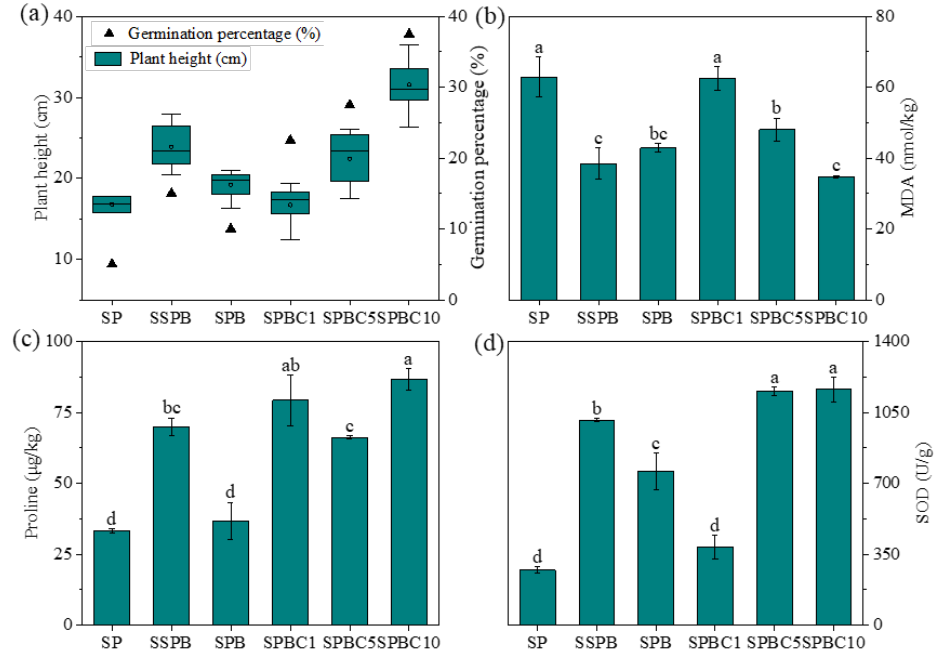
Figure 3. Maize growth and physiological indices in different treatments. ( a ) Plant height and germination percentage; ( b ) MDA content; ( c ) Proline content; ( d ) SOD content. Notes: Different letters indicate significant differences between different treatments ( p < 0.05). “S” represents “unsterilized soil”, “SS” represents “sterilized soil”, “P” represents “plant”, “B” represents “functional bacteria”, “C” represents “biochar”, and the number following the abbreviation represents the proportion of biochar mass to soil mass. Correlations between maize growth and soil quality are analyzed in Figure 4. The plant germination rate was positively correlated with soil nutrient level (r > 0.8, p < 0.05). Plant height was positively correlated with TP (r = 0.853, p < 0.05), and proline content in leaves was positively correlated with nitrogen content in soil (r > 0.8, p < 0.05).